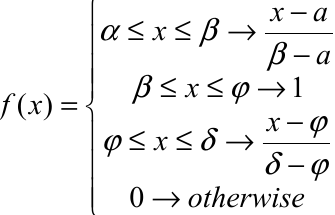
Figure 3. The formulas of the fuzzy logic for the trapezoidal graph are the